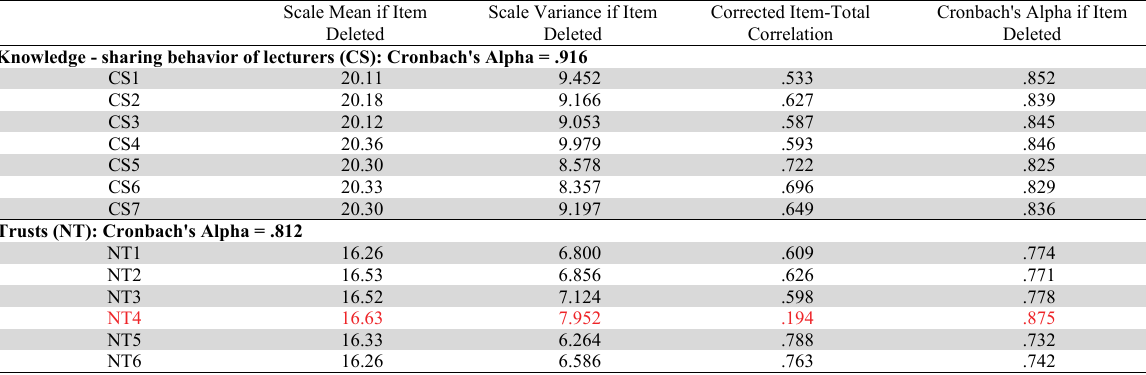
Testing of scales